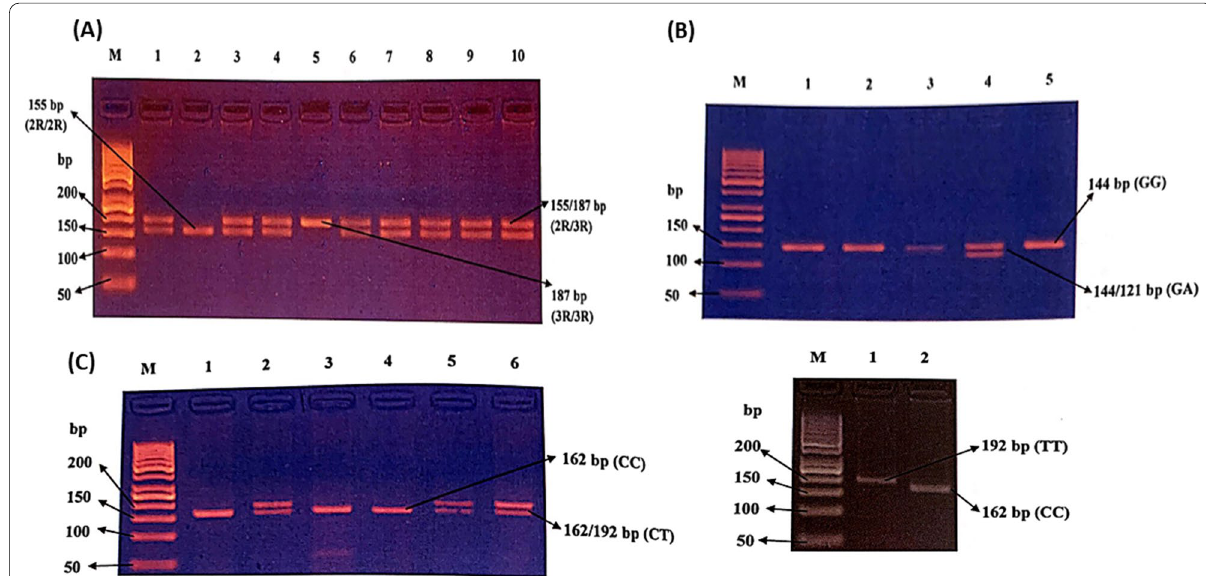
Fig. 1 Agarose gel electrophoresis (3%) showing a PCR products of SNP-19 : Lane (2) represents homozygous (2R/2R, 155 bp) of two repeats of 32 bp, Lane (5) represents homozygous (3R/3R, 187 bp) of three repeats of 32 bp and lanes (1,3,4,6,10) represent heterozygous genotype(2R/3R,155 bp and 187 bp), b RFLP‑PCR products of SNP-43 utilizing FastDigest ® NsiI and c RFLP‑PCR products of SNP-63 utilizing FastDigest ® HhaI M: 50 bp a ladder represents homozygous of three